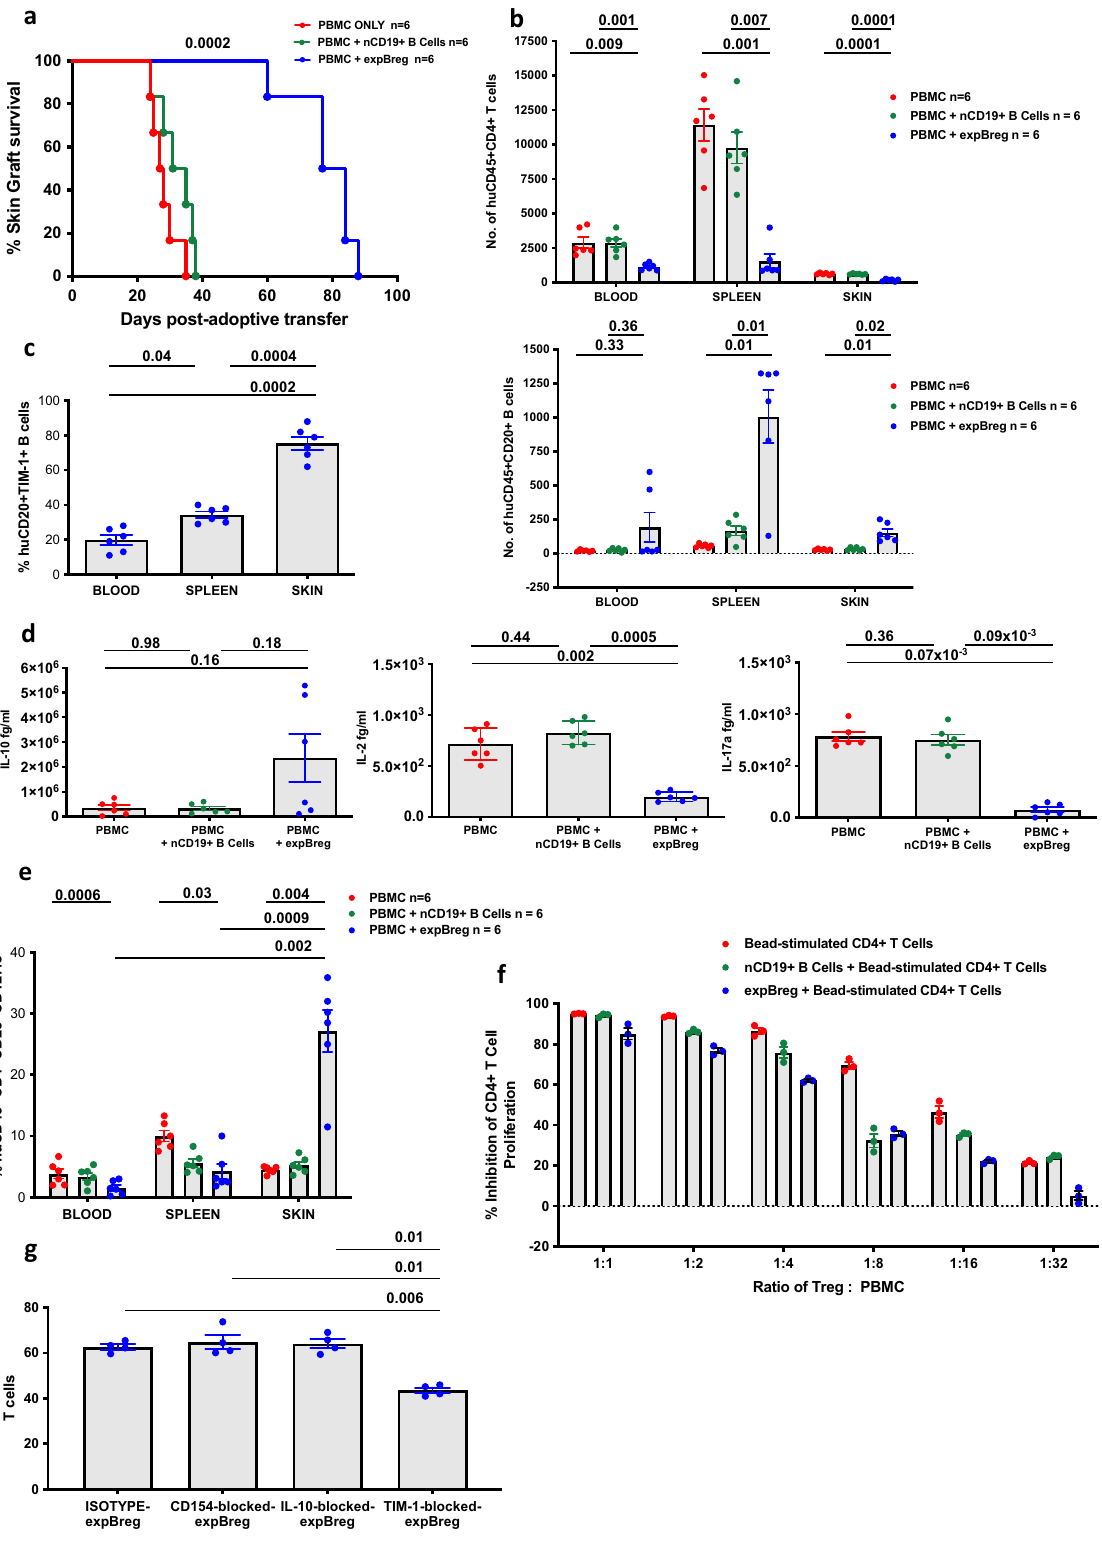
chimerism levels of >1% in the spleen or 0.1% in the peripheral blood were established in the absence of GvHD. Procurement of human skin . Split-thickness human skin at between 8 and 10/ 1000 inches thick were harvested with the use of an air-driven dermatome from the